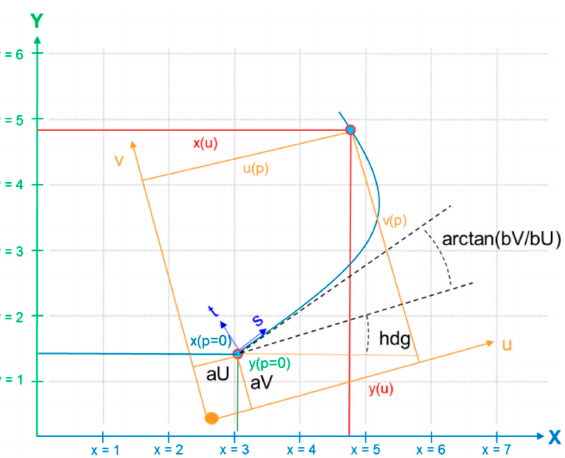
Figure 6. Example of a parametric cubic polynomial (OpenDRIVE V1.6.1).